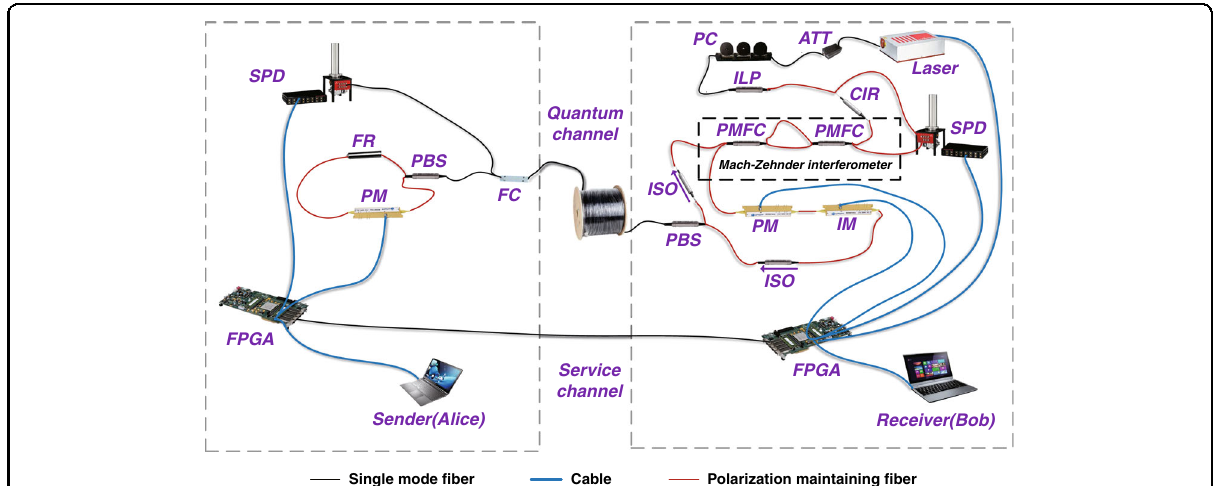
Fig. 2 Experiment setup. Laser: 1550 nm with pulse-repetition frequency 50 MHz; FPGA fi eld programmable gate array, ATT attenuator, PC polarization controller, ILP in-line polarizer, CIR optical circulator, PBS polarization beam splitter, FC 90:10 fi lter coupler, PMFC polarization maintaining fi lter coupler, PM phase modulator, IM intensity modulator with extinction ratio of 45.1 dB, ISO isolator, FR 90 degree Faraday rotator, SPD superconducting nanowire single-photon detector with over 85% detection ef fi ciency, 50 Hz dark count rate and 15 ns reset time. The